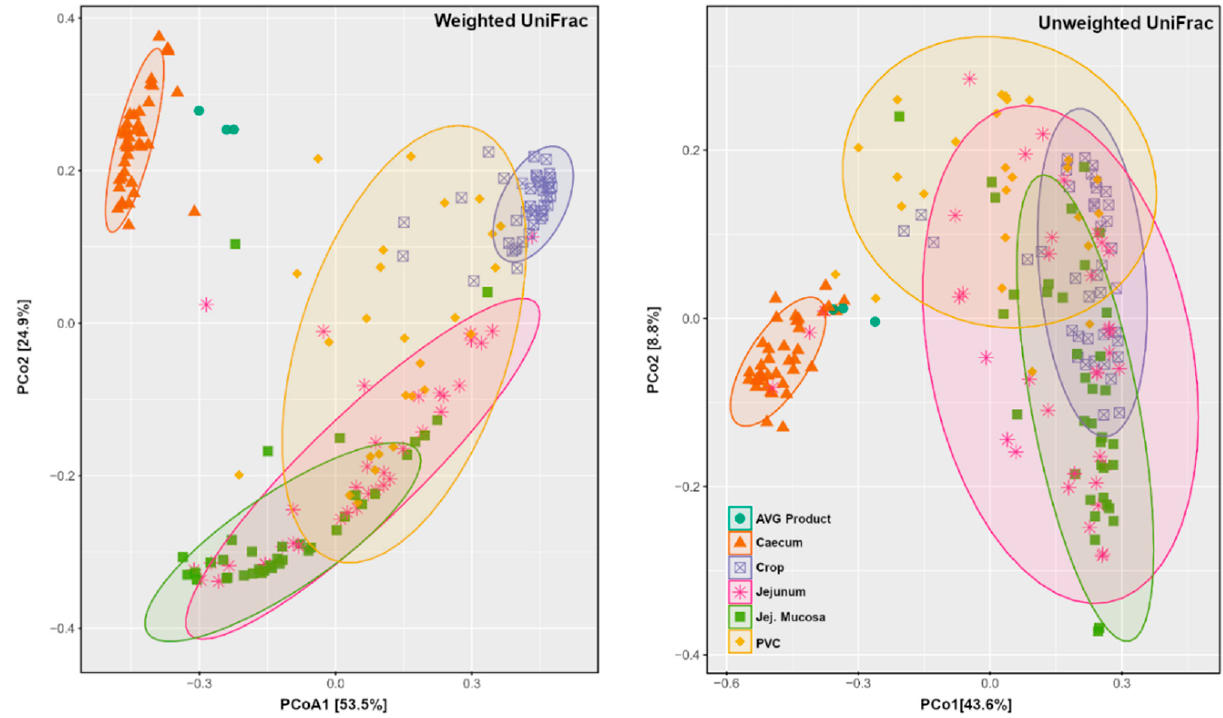
Figure 4. PCoA plots generated using weighted and unweighted UniFrac distance. Jej.Mucosa = Jejunal Mucosa, PVC = Proventriculus. Table 2. PAIRED MANOVA effects of AVG on intestinal microbiota of different gut